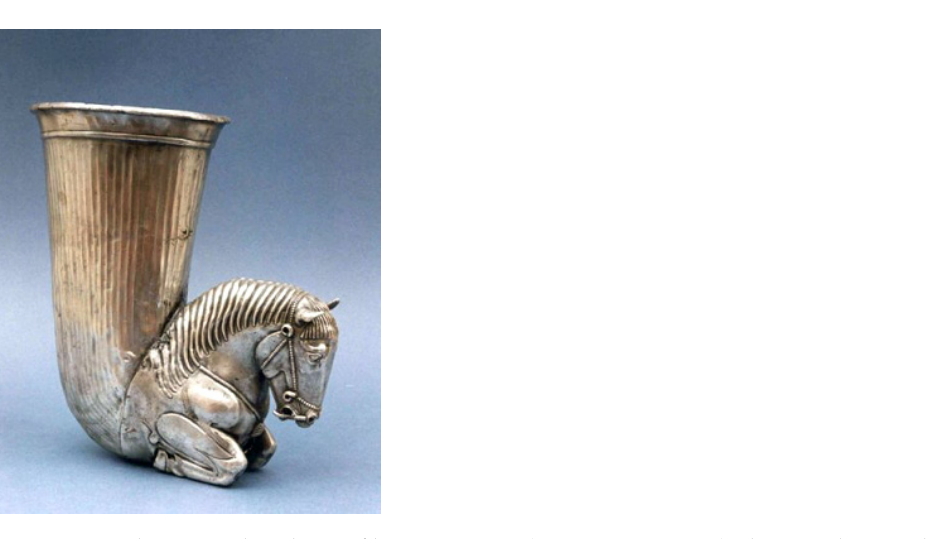
Figure 7. Drinking vessel in shape of horse protome (EHAM inv. no. 19); rhyton, silver; Erebuni, Armenia; (post?) Achaemenid, ca. 4th cent. BCE [image courtesy of the Erebuni Historical and Archaeological Museum-Reserve, Yerevan].